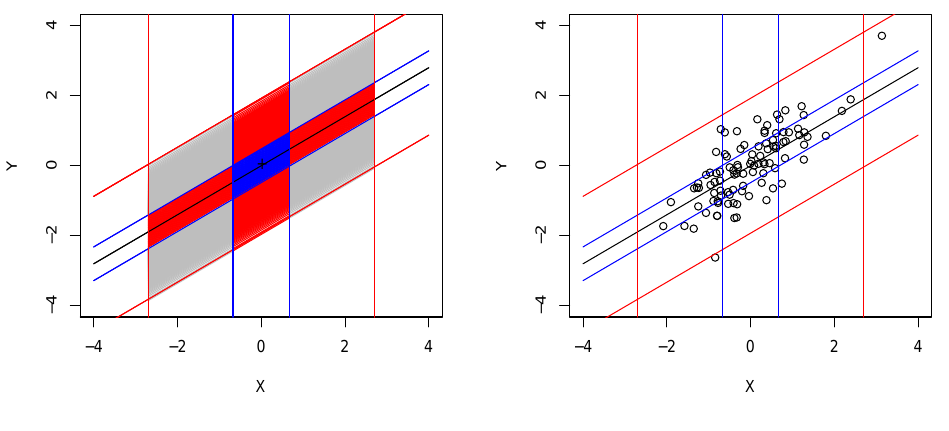
Figure 1: BBP in option 1 (left) for the normal model considered in Example 2.1. The blue region contains the 25% of the data, the four red regions the 49.30234% and the four grey regions the 24.30721% . In the right plot we add 100 simulated data from this model.